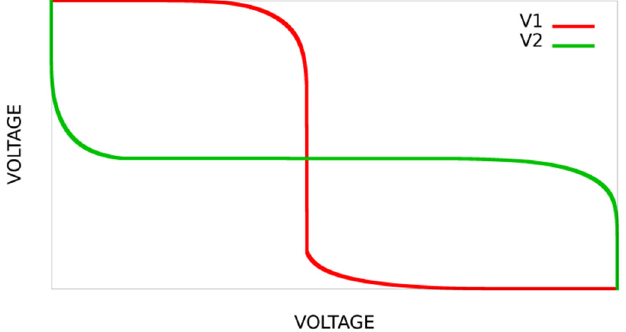
Figure 2. Typical behavior of SNM for a symmetric SRAM cell.